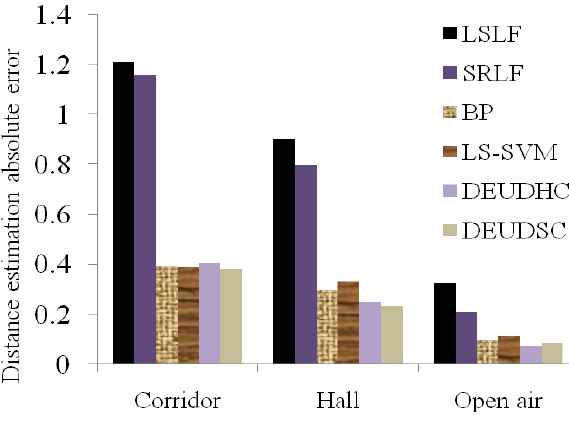
Figure 11. RSSI-D estimation absolute error of different methods in three typical environments.